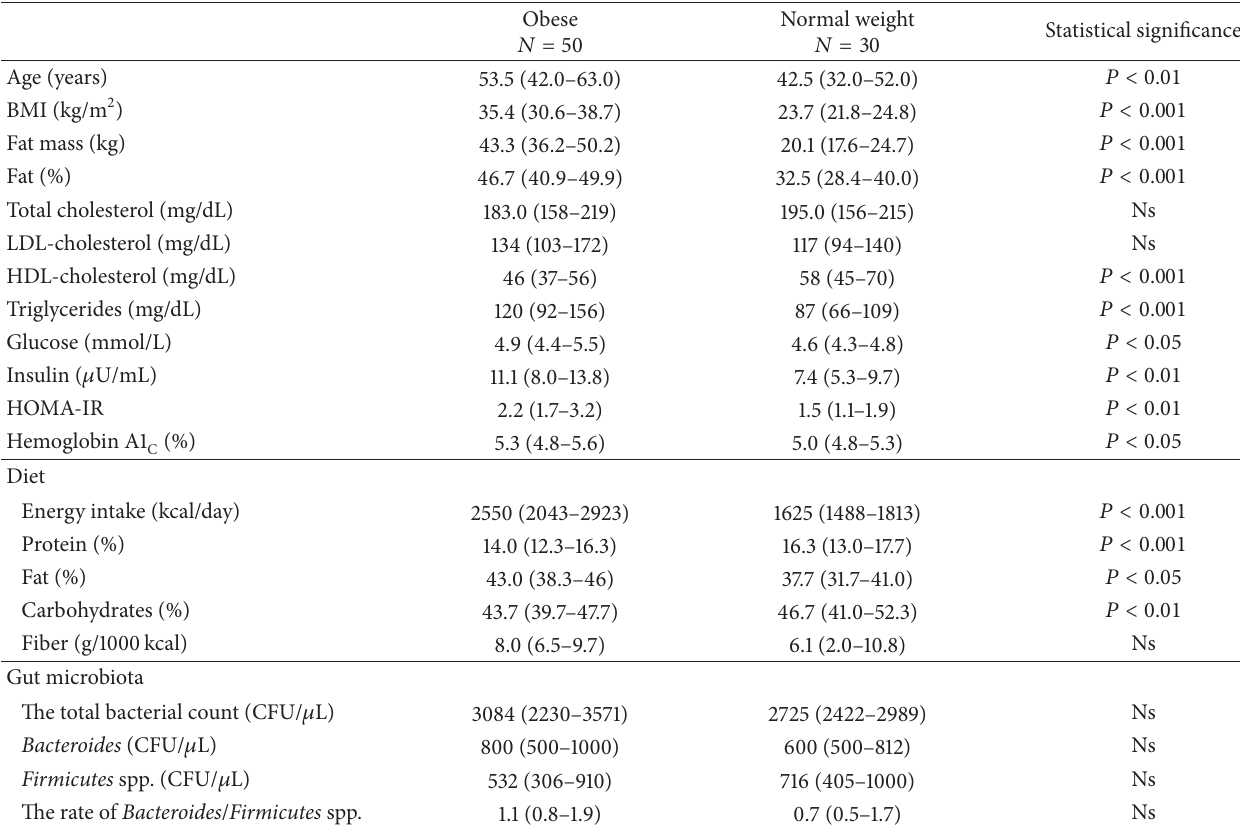
Table 1: The comparison of anthropometric and metabolic parameters in the study groups (median values and interquartile